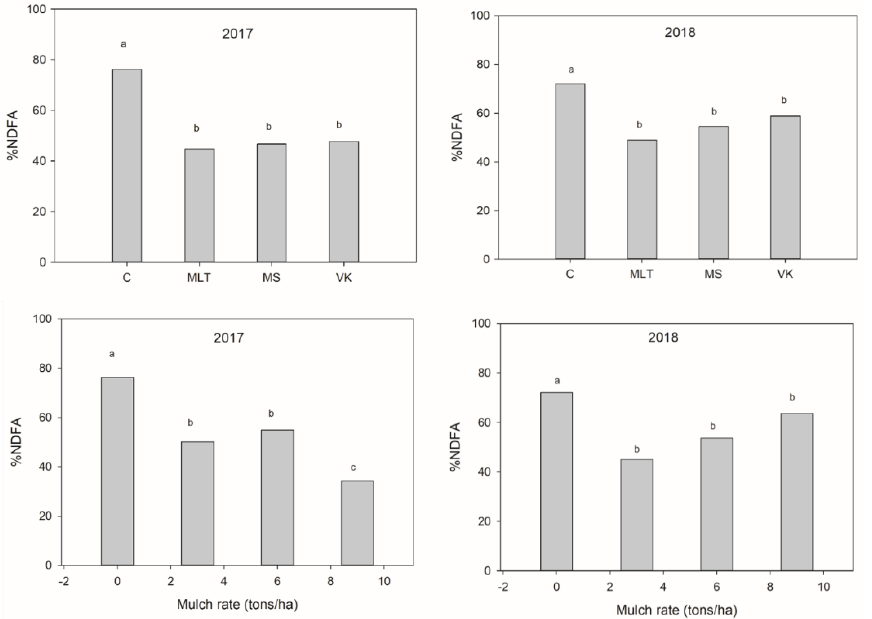
Figure 4. The effect of mulch type and mulch rate on %NDFA (percentage of nitrogen derived from people) at Ofcolaco in 2017 and 2018. MLT is Moringa Oleifera leaves and twigs; MS is M. Oleifera stems; VK is Vachelia Karoo leaves and twigs, and C is the control where no mulch was applied. Different letters (a, b, c) on the bars show significant differences.